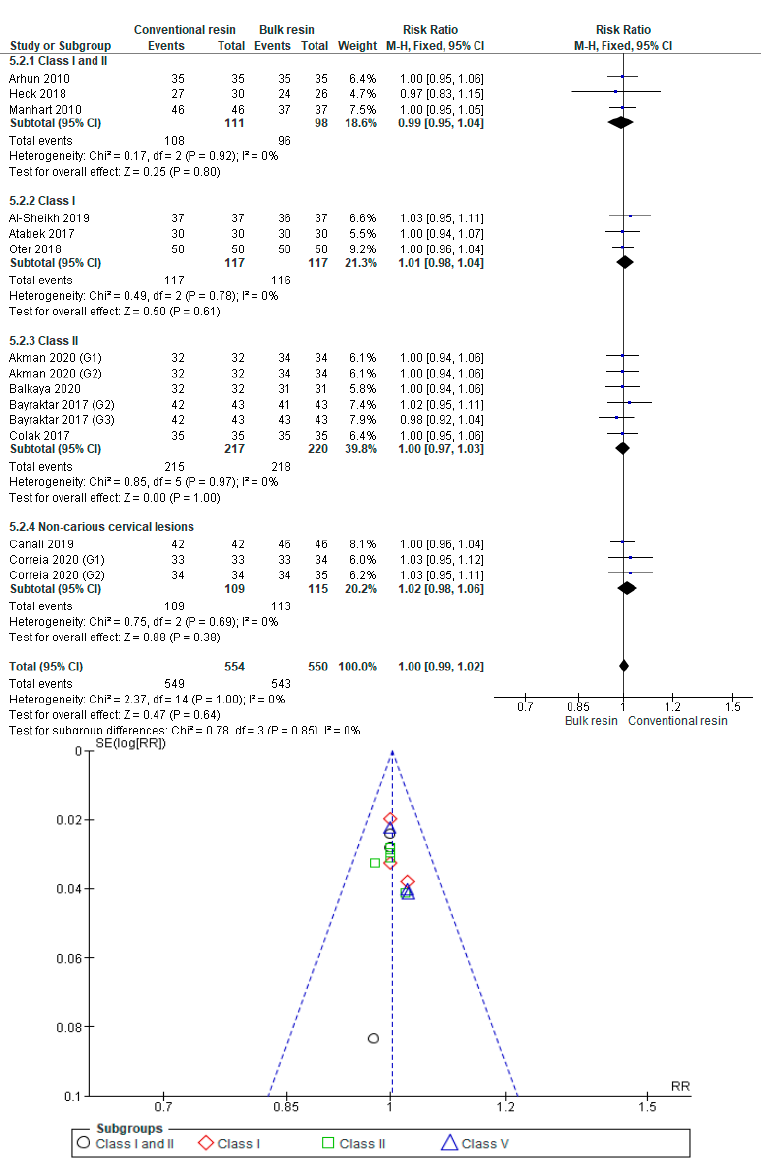
Figure A22. Absence of Secondary Caries: Conventional Resin versus Bulk Resin According to Type of Restoration.